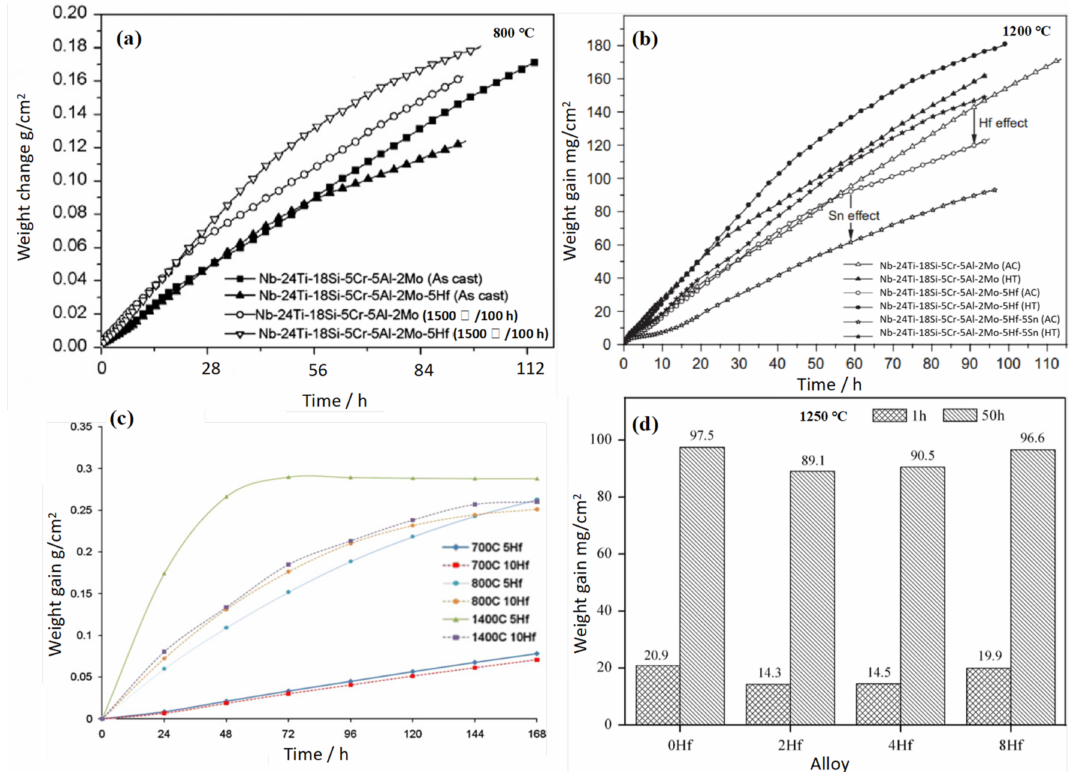
Figure 2. Weight change curves of Nb-Si-based alloys with Hf addition oxidized at ( a ) 800 ◦ C and ( b ) 1200 ◦ C. ( c ) Cyclic oxidation curves for Nb-20Si-20Cr-(5, 10 at.%) Hf alloys. ( d ) Oxidation weight gain histogram of Nb-22Ti-16Si-3Cr-Al-2B-xHf (x = 0 at.%, 2 at.%, 4 at.%, 8 at.%) alloys at 1250 ◦ C. Copyright 2006 Elsevier, 2011 Elsevier and 2015